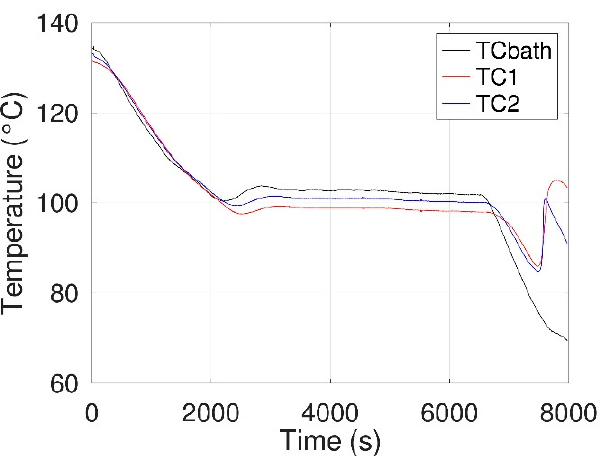
Figure 9. Thermograms (TC1, TC2, and TCbath) obtained at 99 °C (±0.5 °C) with an electrical field (200 V during 5 and 20 s).